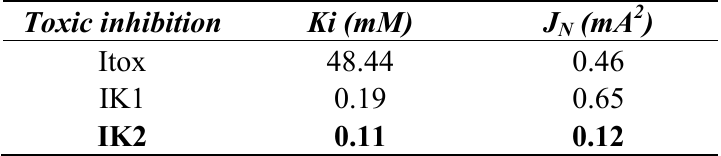
Table S4A. Ferricyanide 0.5 mM.